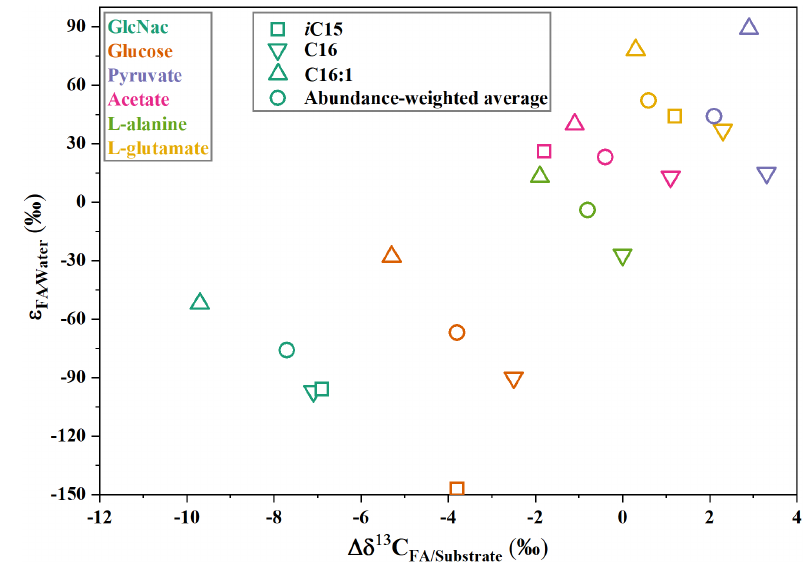
Figure 6. The values of carbon and hydrogen fractionation of fatty acids in S. piezotolerans WP3 growing on different organic substrates. The (cid:49)δ 13 C FA / Substrate values are cited from Chen et al.